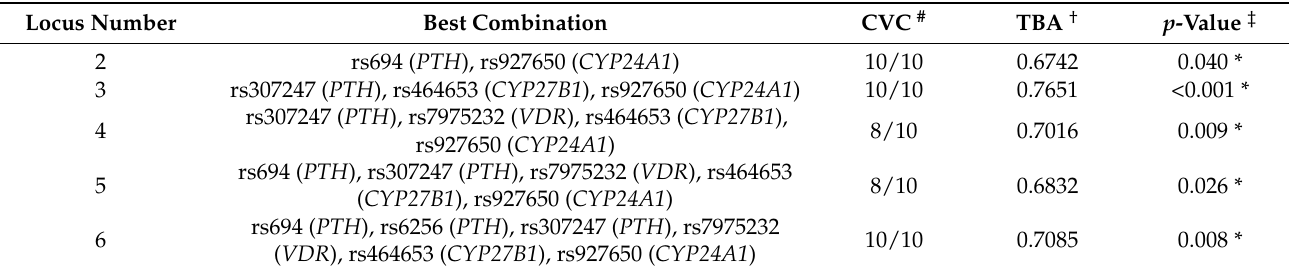
Table 4. Summary of MDR analysis results.